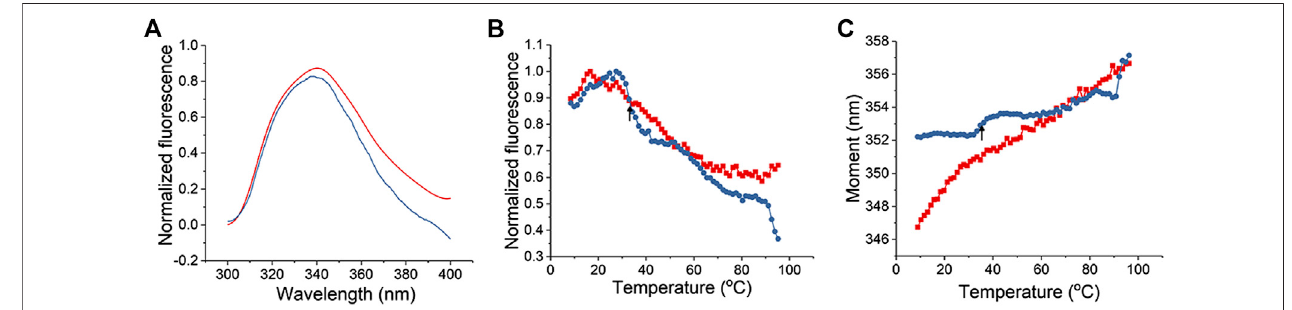
FIGURE 2 | Tertiary structure changes in L-PaF monitored in the presence and absence of ME using intrinsic fl uorescence spectroscopy. (A) Normalized fl uorescencespectraofL-PaFandL-PaFwithMEat10 ° C.Thermalunfoldingpro fi lesweremonitoredby (B) fl uorescenceintensityand (C) MSMpeakposition.Theplots for L-PaF and L-PaF + ME are in red and blue, respectively. The arrow indicates the thermal transition observed for L-PaF when associated with the ME.